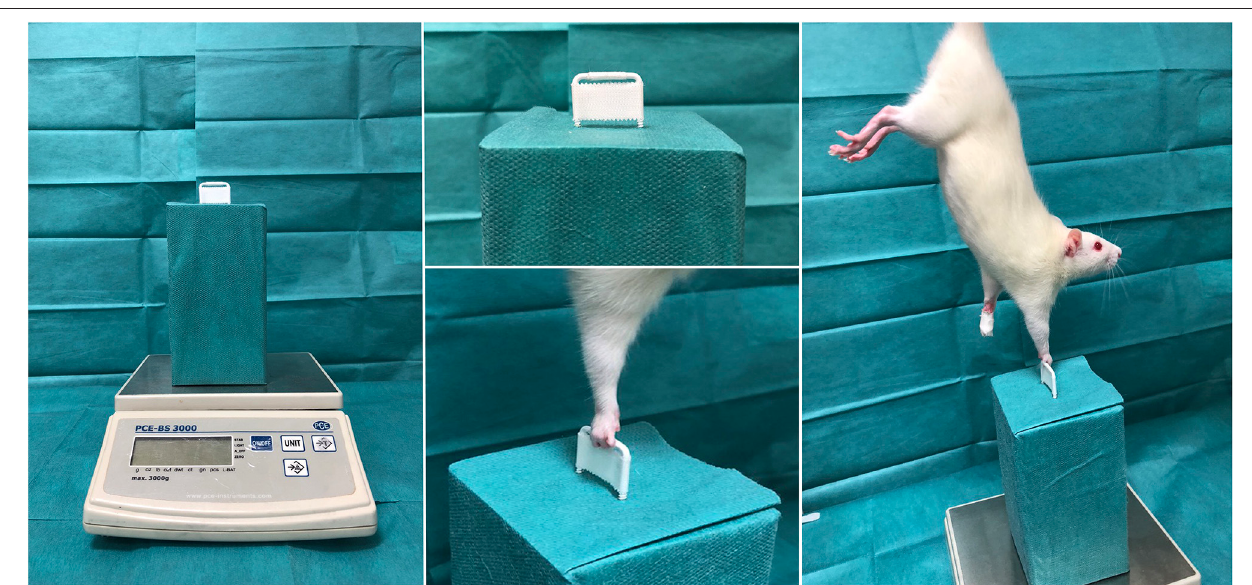
FIGURE 1 | Grip strength test. Shown is the custom-made grip strength apparatus, coupled with a negative measuring scale. The white bar is designed to allow only the fingers to encompass the narrow grip-gap. Once the grip reflex is induced, the experimenter pulls the rat in a steady and reproducible upward motion, whilst the apparatus-coupled scale measures the maximum grip